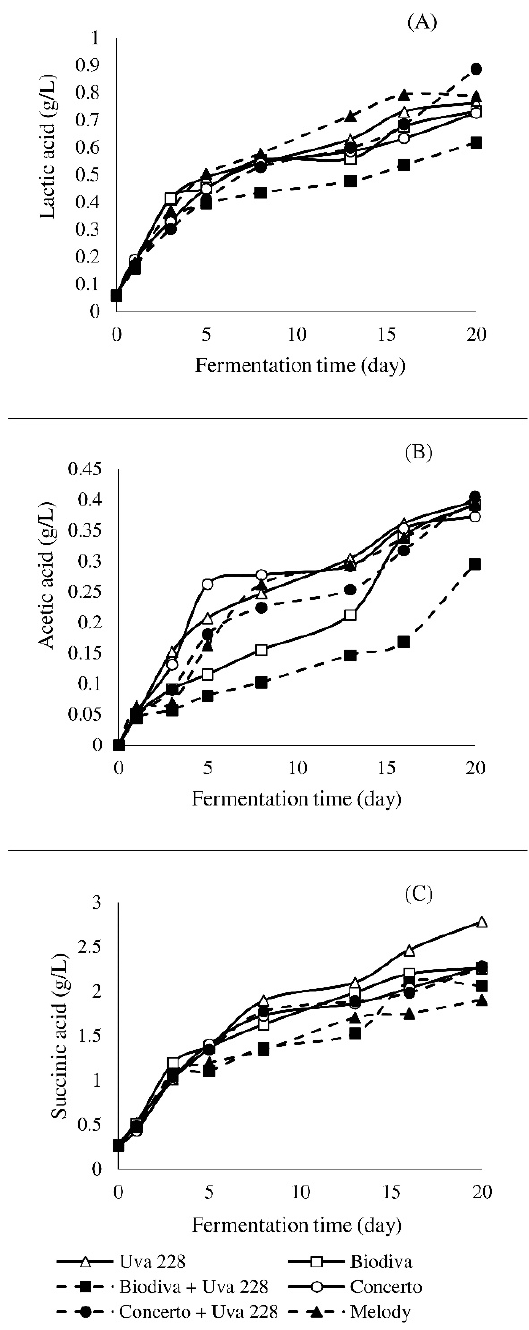
Figure 2. The concentrations of lactic acid ( A ), acetic acid ( B ), and succinic acid ( C ) in apple mash during the fermentation process.